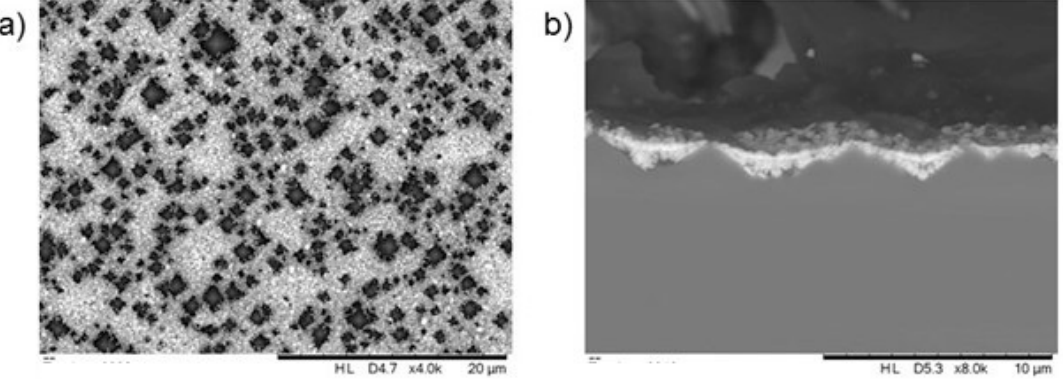
Figure 6. SEM image in ( a ) plane view and ( b ) cross section of the silicon wafer with a typical pyramidal alkaline texture